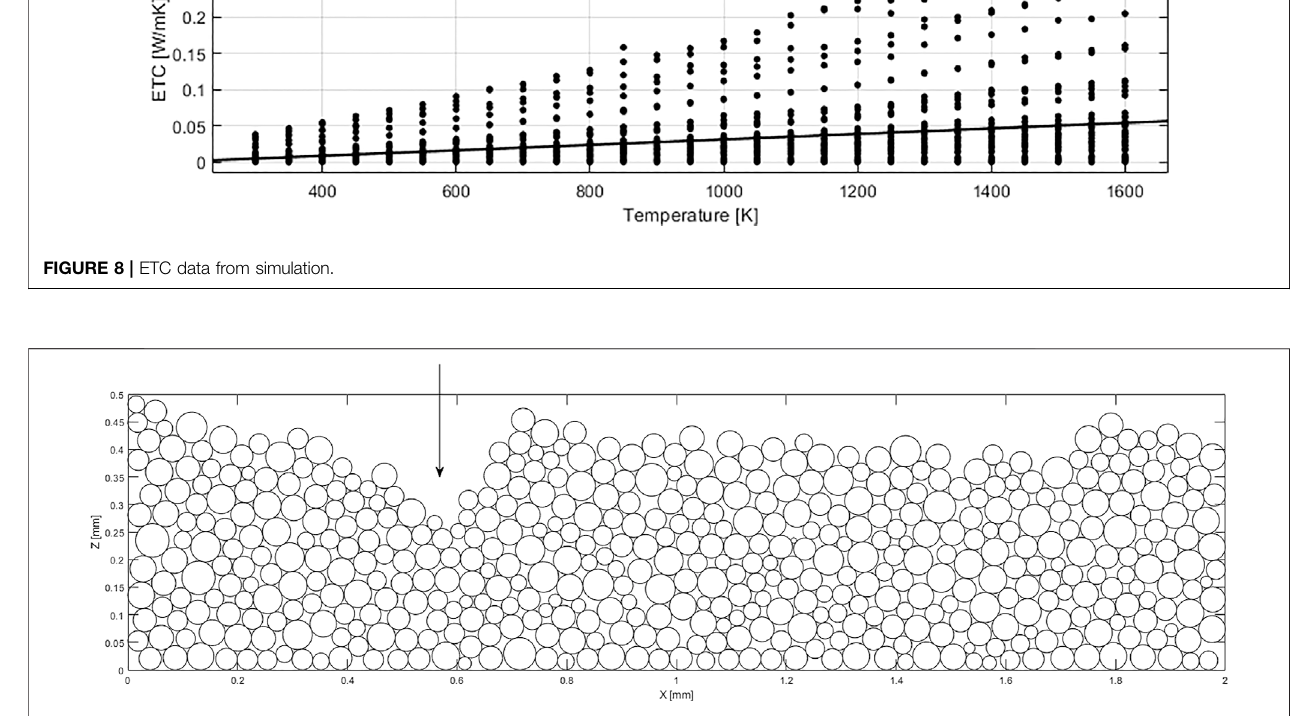
FIGURE 9 | Powder bed con fi guration with notch